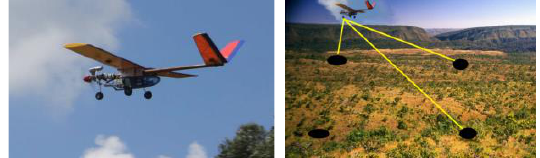
Figure 3: The Ararinha (left) and the case study illustration